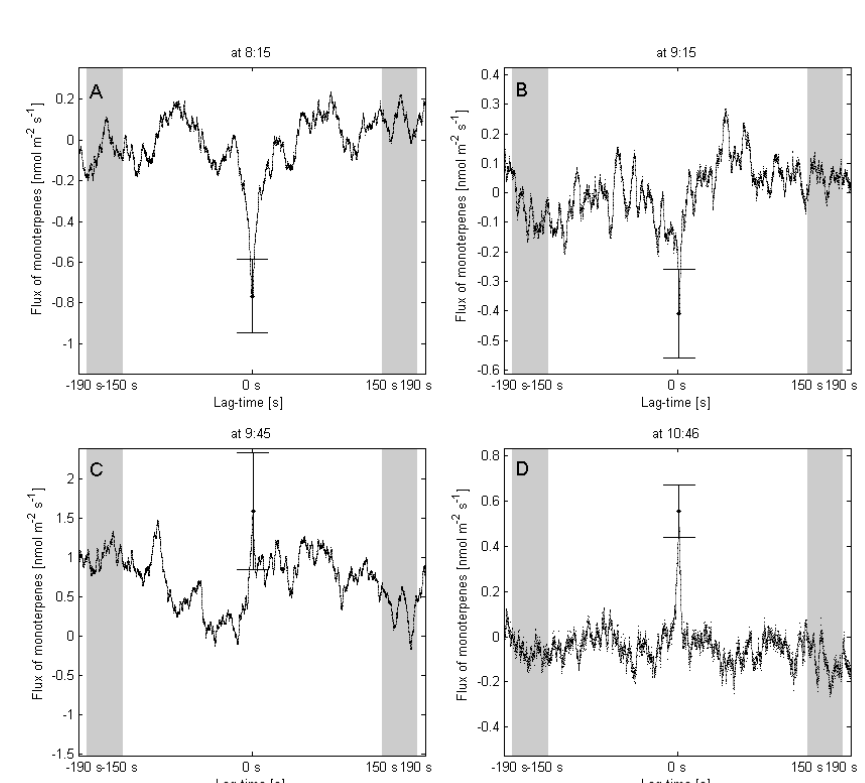
Figure 2. Monoterpenes flux (137.1330 m/z) during the morning of grass cutting on 5 August. The clear deposition to the intact grassland (A) , changes during the grass cutting between 9 and 10:30 (B) and (C) into an emission (D) from some of the cut grass species that were left to dry on the field. The uncertainty of the flux is calculated by multiplying the standard deviation of the shaded areas with 1.96 to get the 95% confidence intervals indicated with bars.